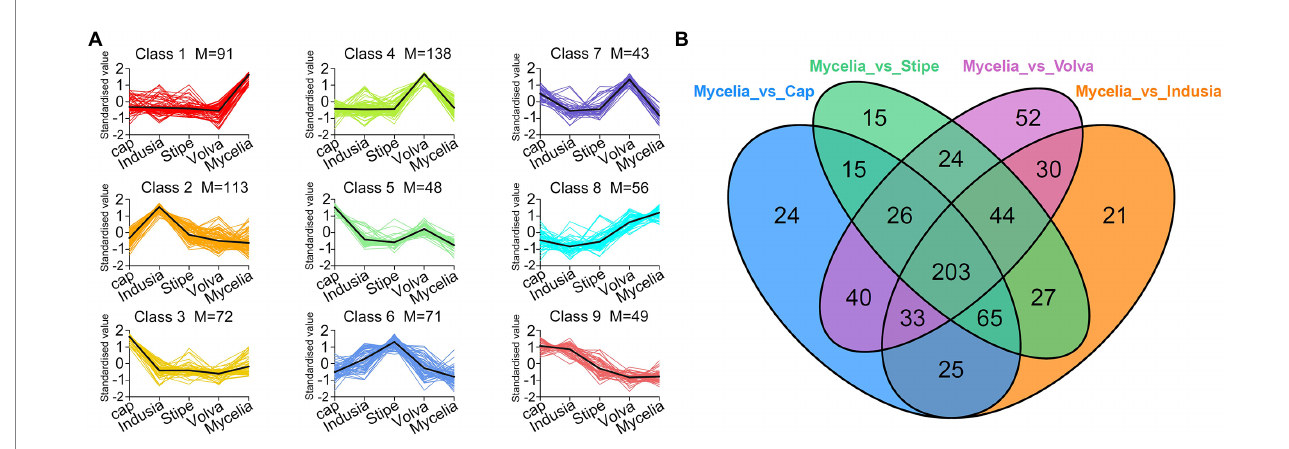
FIGURE 6 Analysis of the distribution characteristics of metabolites in different DI tissue types. (A) K-means clustering of metabolites of five DI tissue types. The abscissa represents the sample group, the ordinate represents standardized relative metabolite content, and the class represents the metabolite category number with the same trend in five DI tissue types. M represents the number of metabolites in this class. (B) Venn diagram shows differential metabolites of different comparison groups.